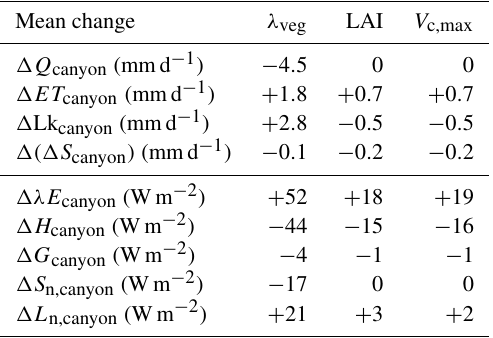
Table 5. Mean change over the whole simulation period of surface runoff within the canyon ( (cid:49)Q canyon ), water percola- tion at the bottom of the soil ( (cid:49) Lk canyon ), change in water storage on the surface and in the soil ( (cid:49)((cid:49)S canyon ) ), latent heat flux ( (cid:49)λE canyon ), sensible heat flux ( (cid:49)H canyon ), con- ductive heat flux into or out of buildings and ground surface ( (cid:49)G canyon ), net absorbed shortwave radiation ( (cid:49)S n,canyon ), and net absorbed longwave radiation ( (cid:49)L n,canyon ) at λ G,veg = 100% compared to λ G,veg = 0%, LAI = 5 compared to LAI = 0.5, and V c,max = 120µmolCO 2 s − 1 m − 2 compared to V c,max = 20µmolCO 2 s − 1 m − 2